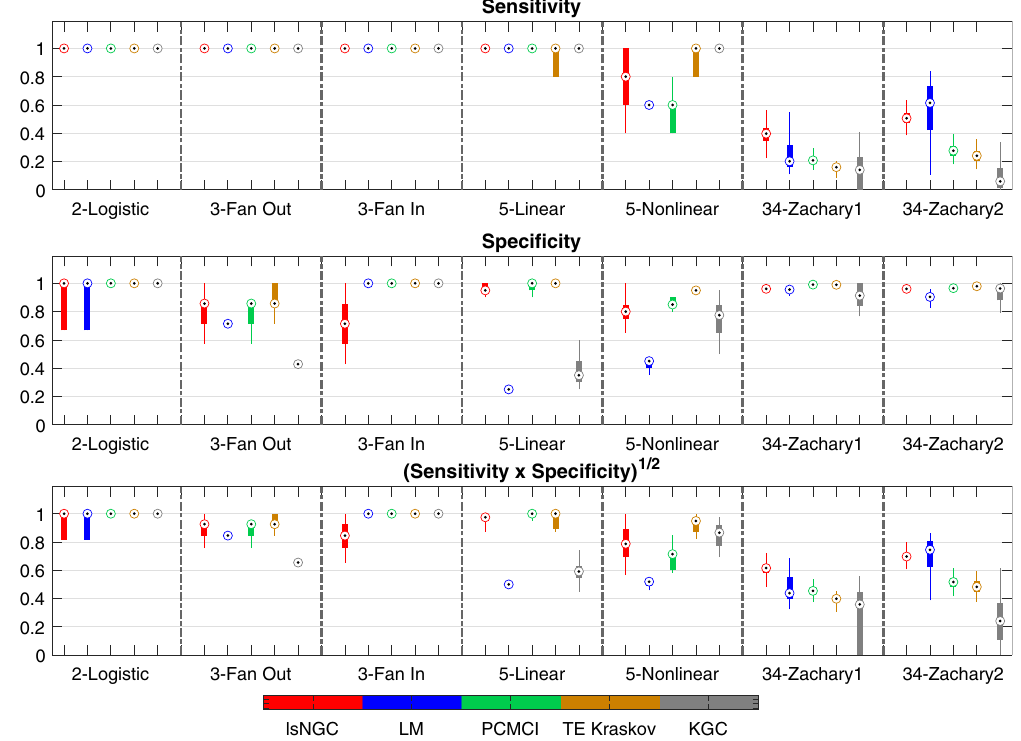
Figure 5. Sensitivity and specificity results for the three approaches across all networks, visualized as boxplots. Figure generated with MATLAB R2016a 40 . The bottom end of the box represents the first quartile and the top of the box represents the third quartile. The circle with a dot in the box represents the distribution median. We also plot a measure combining the two measure to estimate overall performance. In general, we observe lsNGC works consistently well for all